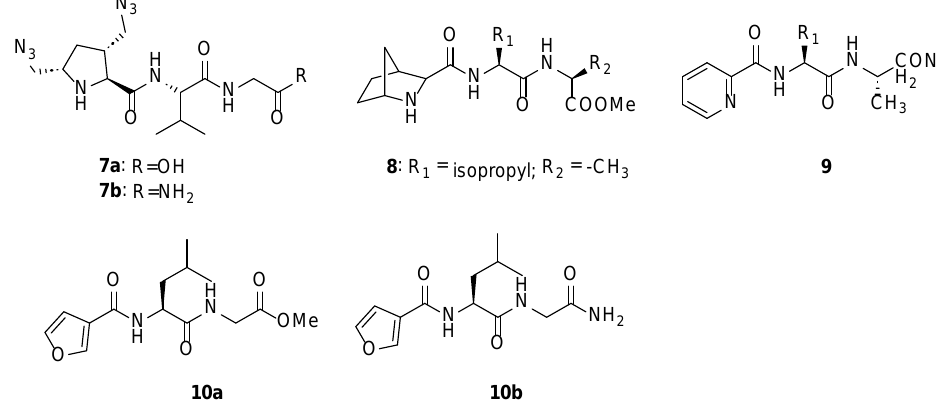
Figure 8. Further examples of PLG-derived peptidomimetics.